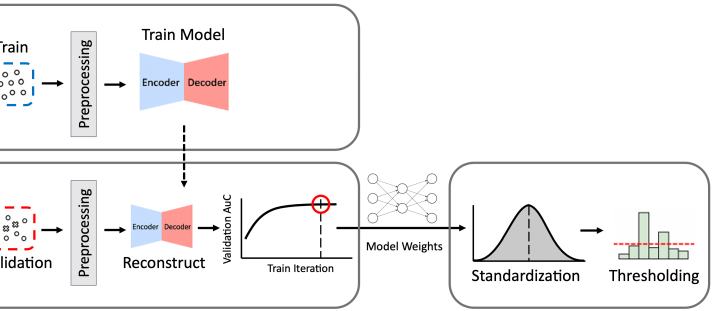
Figure 2. The process of building autoencoder models. Train denotes the data for training, and Validation denotes the data for validation. The process consists of three phases: training, model selection, and